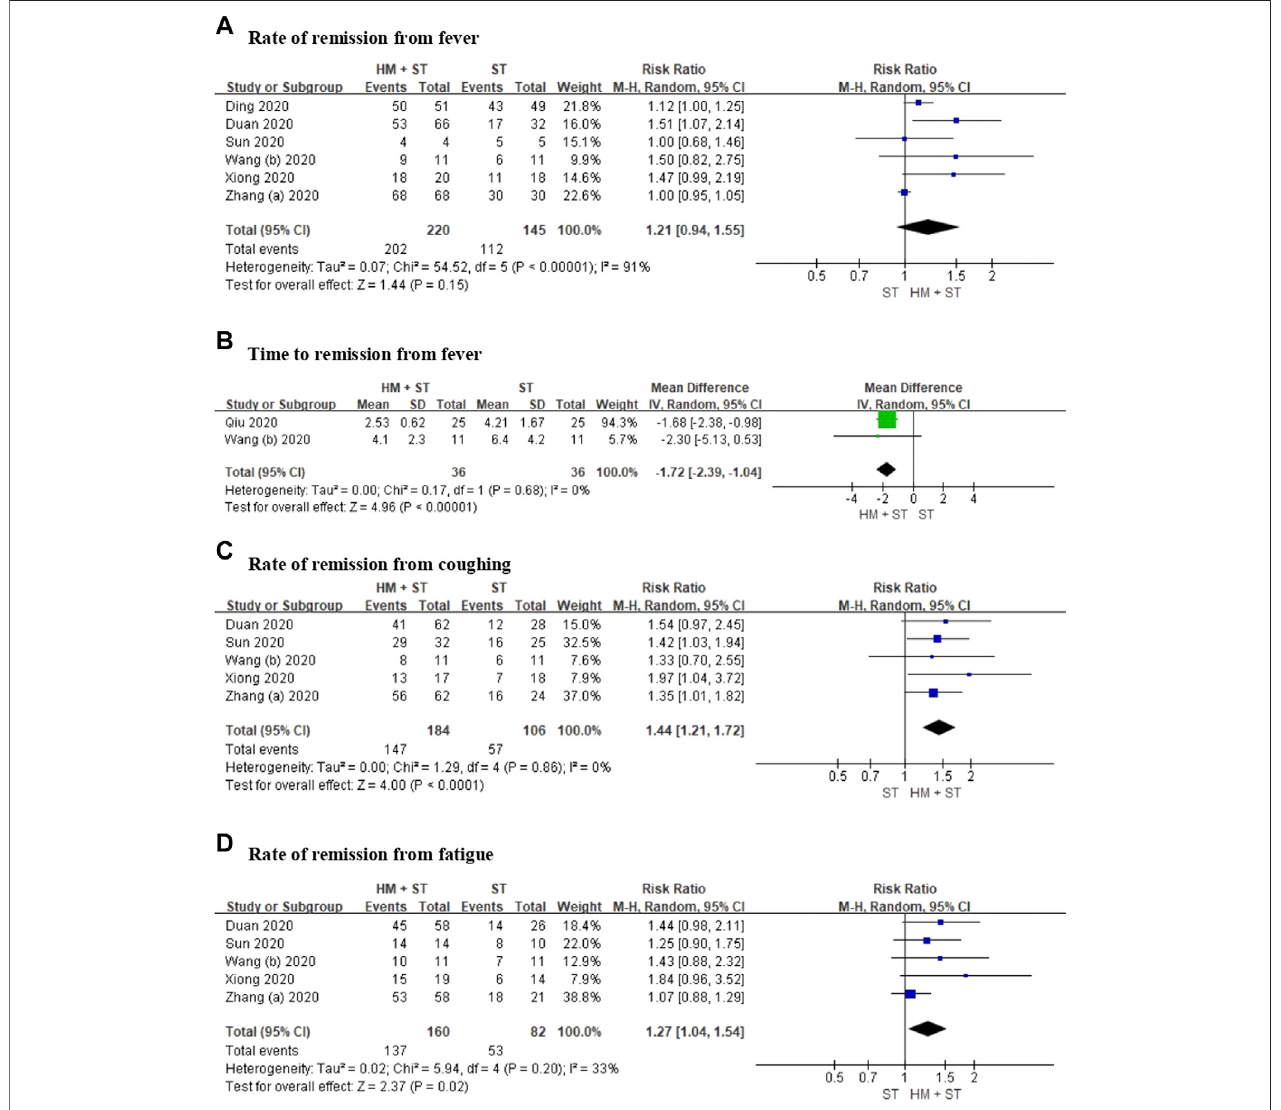
FIGURE 3 | Forest plot for (A) rate of remission from fever, (B) time to remission from fever, (C) rate of remission from coughing, (D) rate of remission from fatigue.